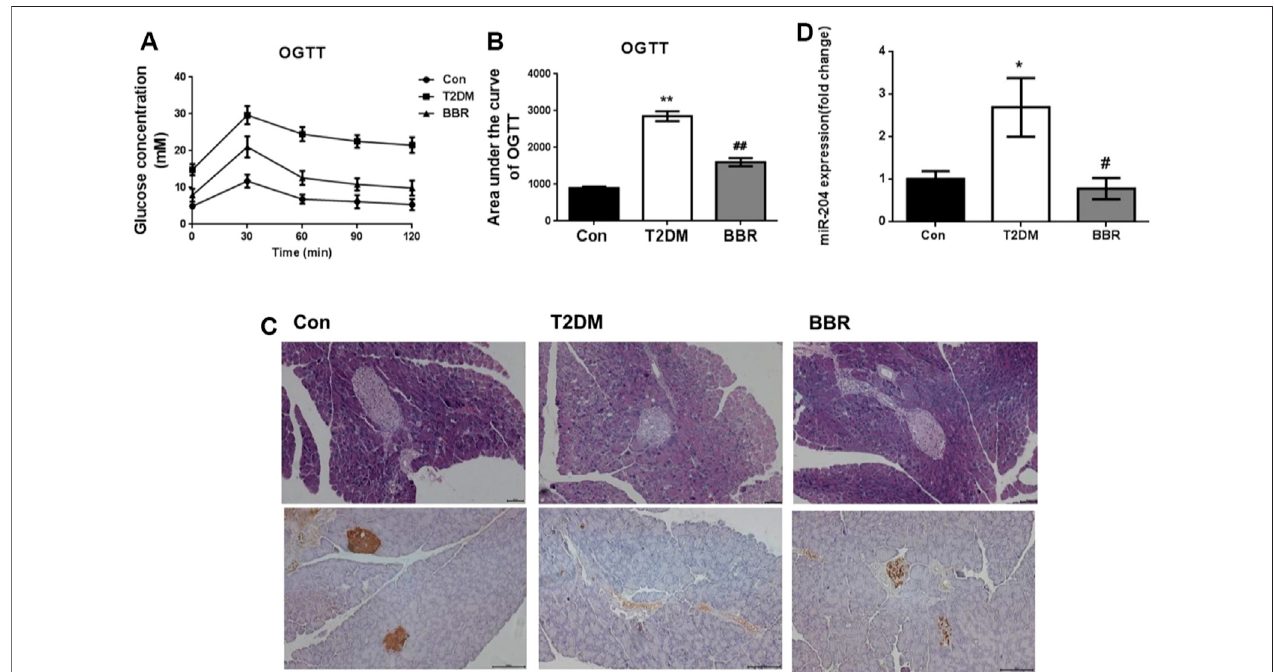
FIGURE 6 | Effects of BBR on OGTT, islet morphology, insulin secretion and sera miR-204 levels in type 2 diabetic mice (A, B) After administration of BBR 160 mg/kg by gavage for 4 weeks, the curve of OGTT and the area under the curve were measured. CON: control group; T2DM: type 2 diabetes mellitus group. BBR: BBR treatment group. OGTT: oral glucose tolerance test. (C) Histology were used to observe islet morphology, and pancreatic insulin level are measured using Immunohistochemistry(200 × ) (D) TheRNAofislettissuewasextracted,andmiR-204levelswasdetectedbyRT-PCR.Datawasexpressedasmean ± SEM, n (cid:1) 5, * p < 0.05, ** p < 0.01 compared with Con group; # p < 0.05, ## p < 0.01 compared with T2DM